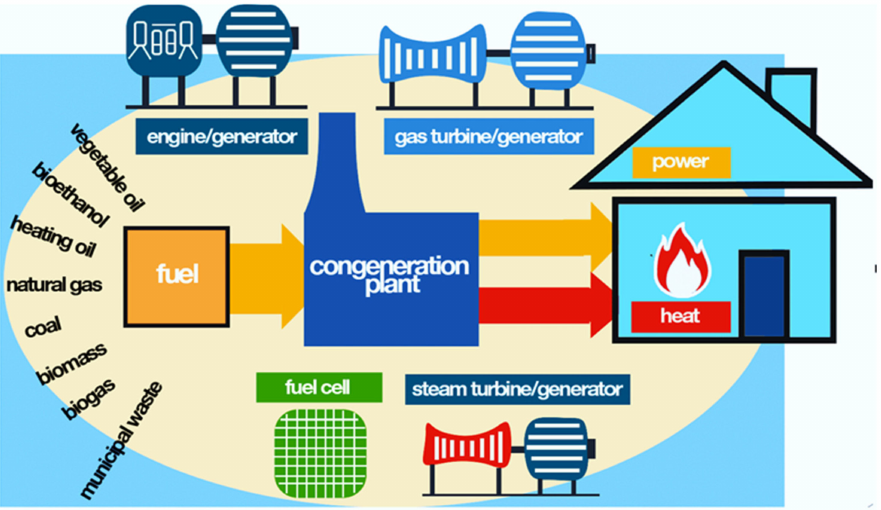
Figure 4. Cogeneration principle. Source: www.cogeneurope.eu (accessed on 20 October